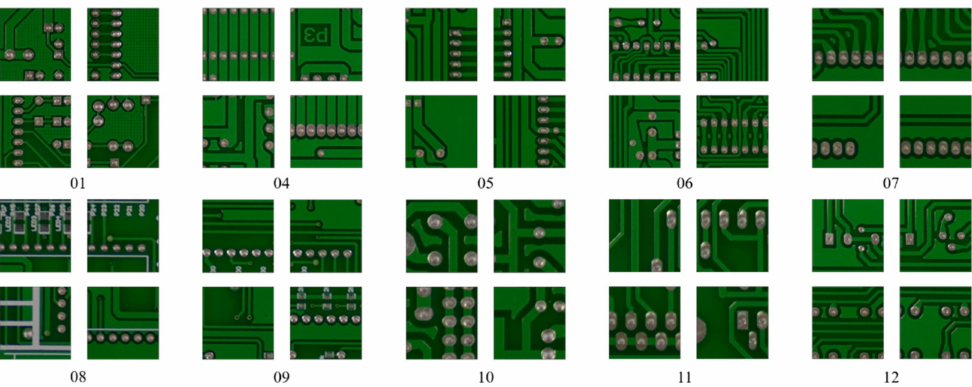
Figure 1. The 400 × 400 PCB images are cropped from Huang and Wei’s PCB dataset [12]. The number below each PCB image is the name of the reference PCB. The numbers below the cropped images are the name of the reference image files. Table 1. Overall PCB dataset configuration. The adjusted size is the size adjusted from the original 4608 × 3456 resolution to the size of each reference PCB. The number in parentheses of the total refers to the number of artificially generated defects. Reference